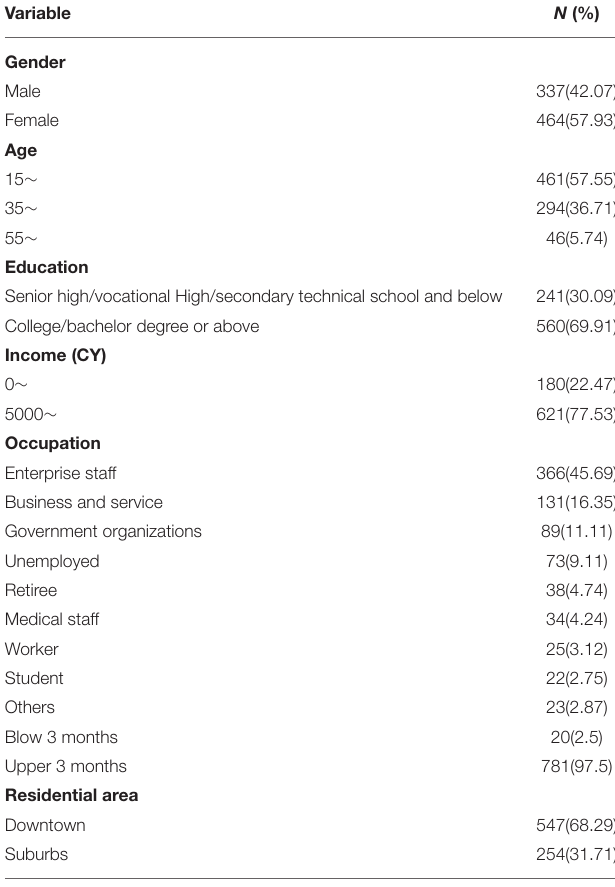
TABLE 1 | Sociodemographic characteristics of the